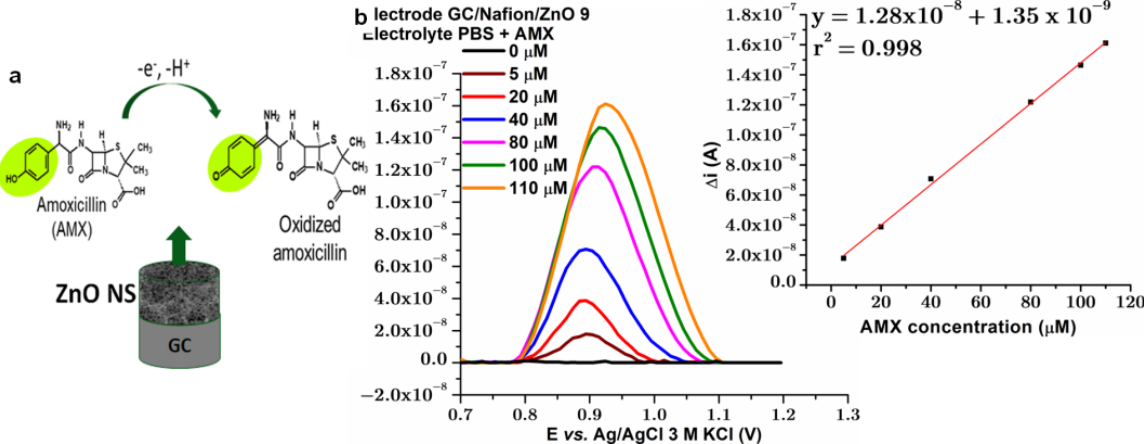
Figure 9. ( a ) Redox reaction of AMX; ( b ) DPV curves in PBS + AMX 6 different concentrations; and calibration curve using GC/Nafion/ZnO 9 electrode.